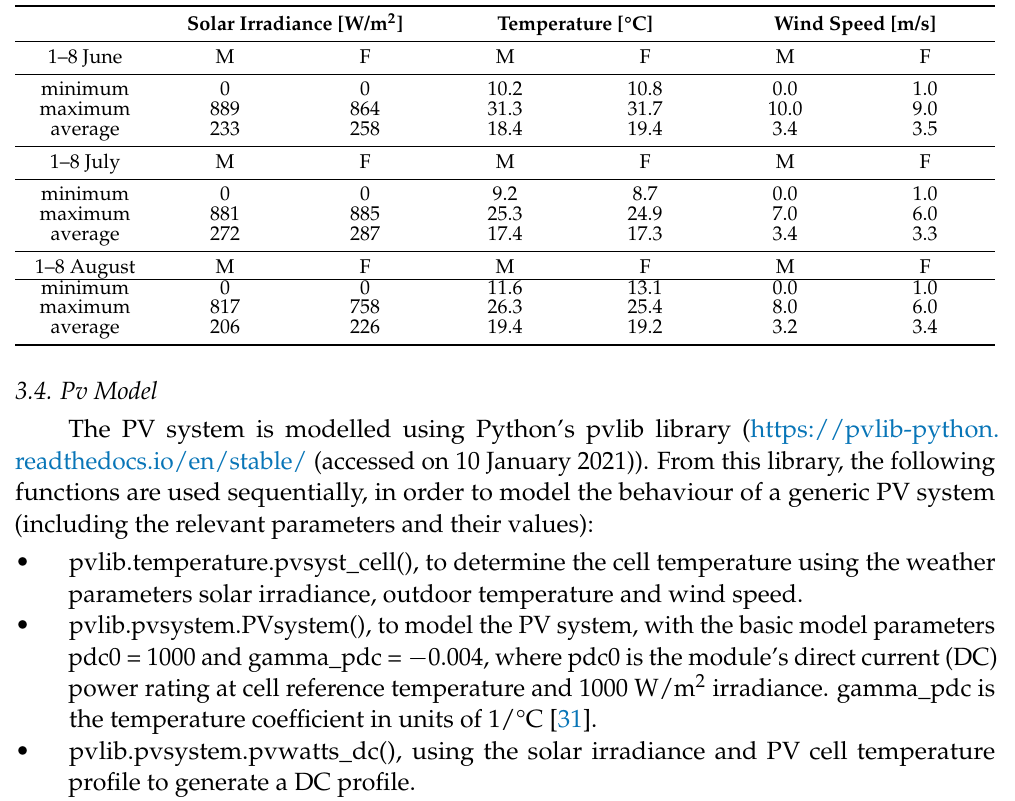
Table 1. Summary statistics of the input data. The following labels are used: M for measurement data and F for the day-ahead forecast.